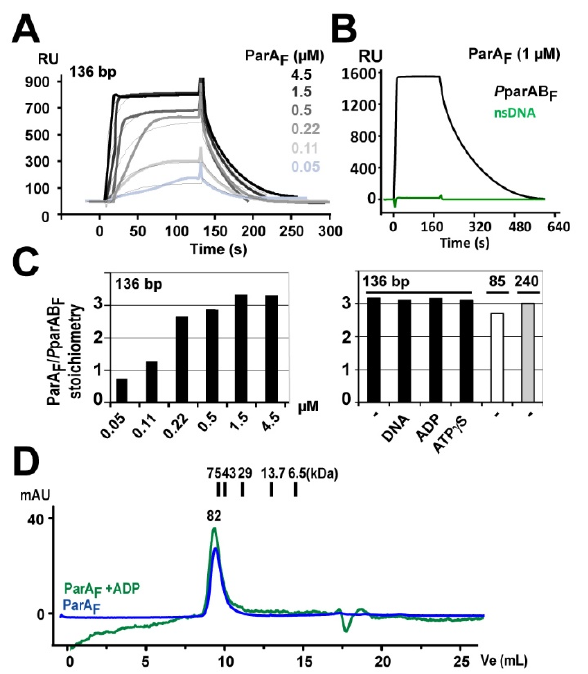
Figure 2. Three ParA F dimers bind to the P parAB F promoter. ( A ) Surface Plasmon Resonance analysis of ParA F binding to P parAB F . 300 RU of a 136-bp biotinylated DNA fragment were immobilized on a streptavidin chip. Increasing concentrations of ParA F ranging from 0.05 to 4.5 µM in BD buffer without adenine nucleotide were injected at 20 µL.min − 1 at time 0. Dose − response sensorgrams and corresponding fits according to 1:1 Langmuir interaction model are represented by bold and light curves, respectively. ( B ) ParA F binds specifically to the promoter region in the absence of ADP. ParA F DNA binding activity was measured by SPR using 136-bp DNA fragments containing P parAB F (530 RU; black line) or nsDNA (597 RU; green line) immobilized on two different channels of the same sensor chip. ParA F (1 µM) was injected at 10 µL.min − 1 at time 0 for 180 s before dissociation. ( C ) Stoichiometry of ParA F dimers binding. ParA F dimers bound per P parAB F DNA molecule was calculated according to the formula S = Rmax /[(MW A /MW L ) * R L ], where Rmax is the maximum response, MW A is the molecular weight of ParA F and MW L and R L are the molecular weight and the amount of ligand immobilized, respectively. ADP and non-hydrolysable ATP analog (ATP γ S) were used at 1 mM and, where indicated, sonicated salmon sperm DNA is added at 1 mg.mL − 1 . Biotinylated DNA fragments of 85-, 136- and 240-bp, immobilized at 200, 300 and 530 RU, respectively, were infused with 5, 1.5 and 1.85 µM of ParA F , respectively. ( D ) ParA F is a dimer in solution in the apo- and ADP-form. Analytical gel filtration chromatography of ParA F (4 µM) pre-incubated with (green line) or without (blue line) 1 mM ADP using a Superdex 75 column was monitored at 280 nm. A drift of the baseline is observed throughout the elution in the presence of ADP, probably to a slight difference in the buffers used during the experiment. The elution peak (9.5 mL) corresponds to 82 kDa. Conalbumin (75 kDa), ovalbumin (43 kDa), anhydrate carbonic (29 kDa), ribonuclease A (13.7 kDa) and aprotinin (6.5 kDa) were used as molecular weight standards and eluted at 9.66, 10.55, 11.74, 13.35 and 15 mL, respectively.